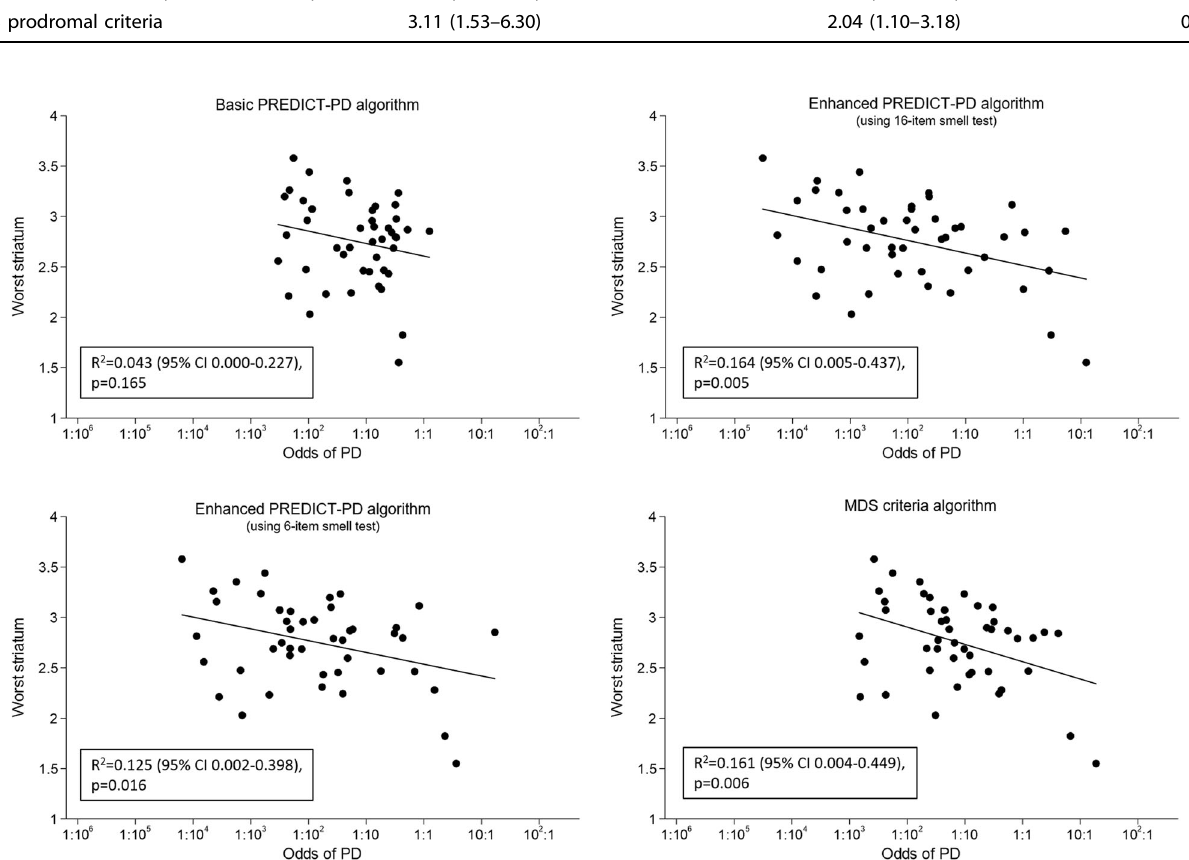
Fig. 2 Scatterplots and regression lines of risk estimates (presented as odds) against striatal binding ratios on DaT-SPECT imaging. Risks calculated using the basic PREDICT-PD algorithm, the enhanced PREDICT-PD algorithm using a 16 item smell test, the enhanced PREDICT-PD algorithm using a 6-item smell test and the MDS prodromal criteria algorithm are shown in the top left, top right, bottom left and bottom right panels of the fi gure